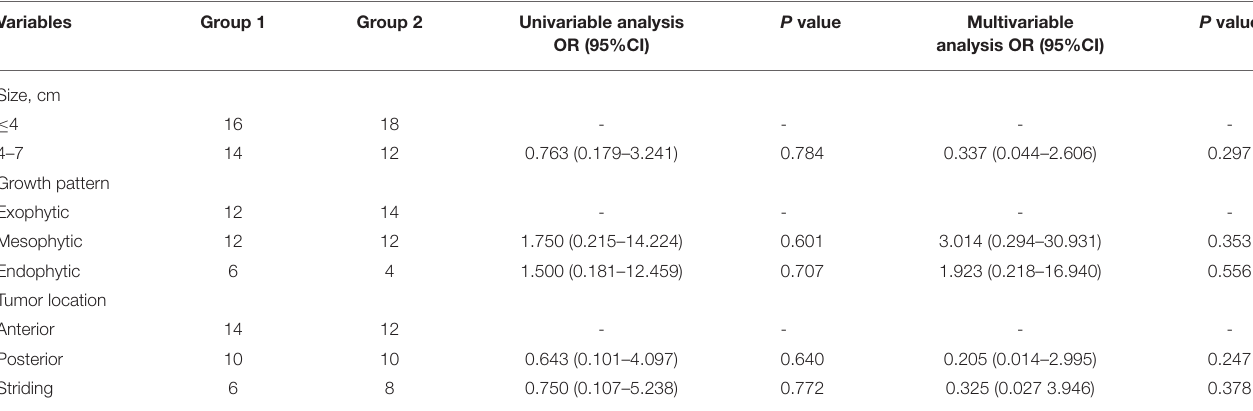
TABLE 3 | The influence of tumor characteristics on the choice of suture